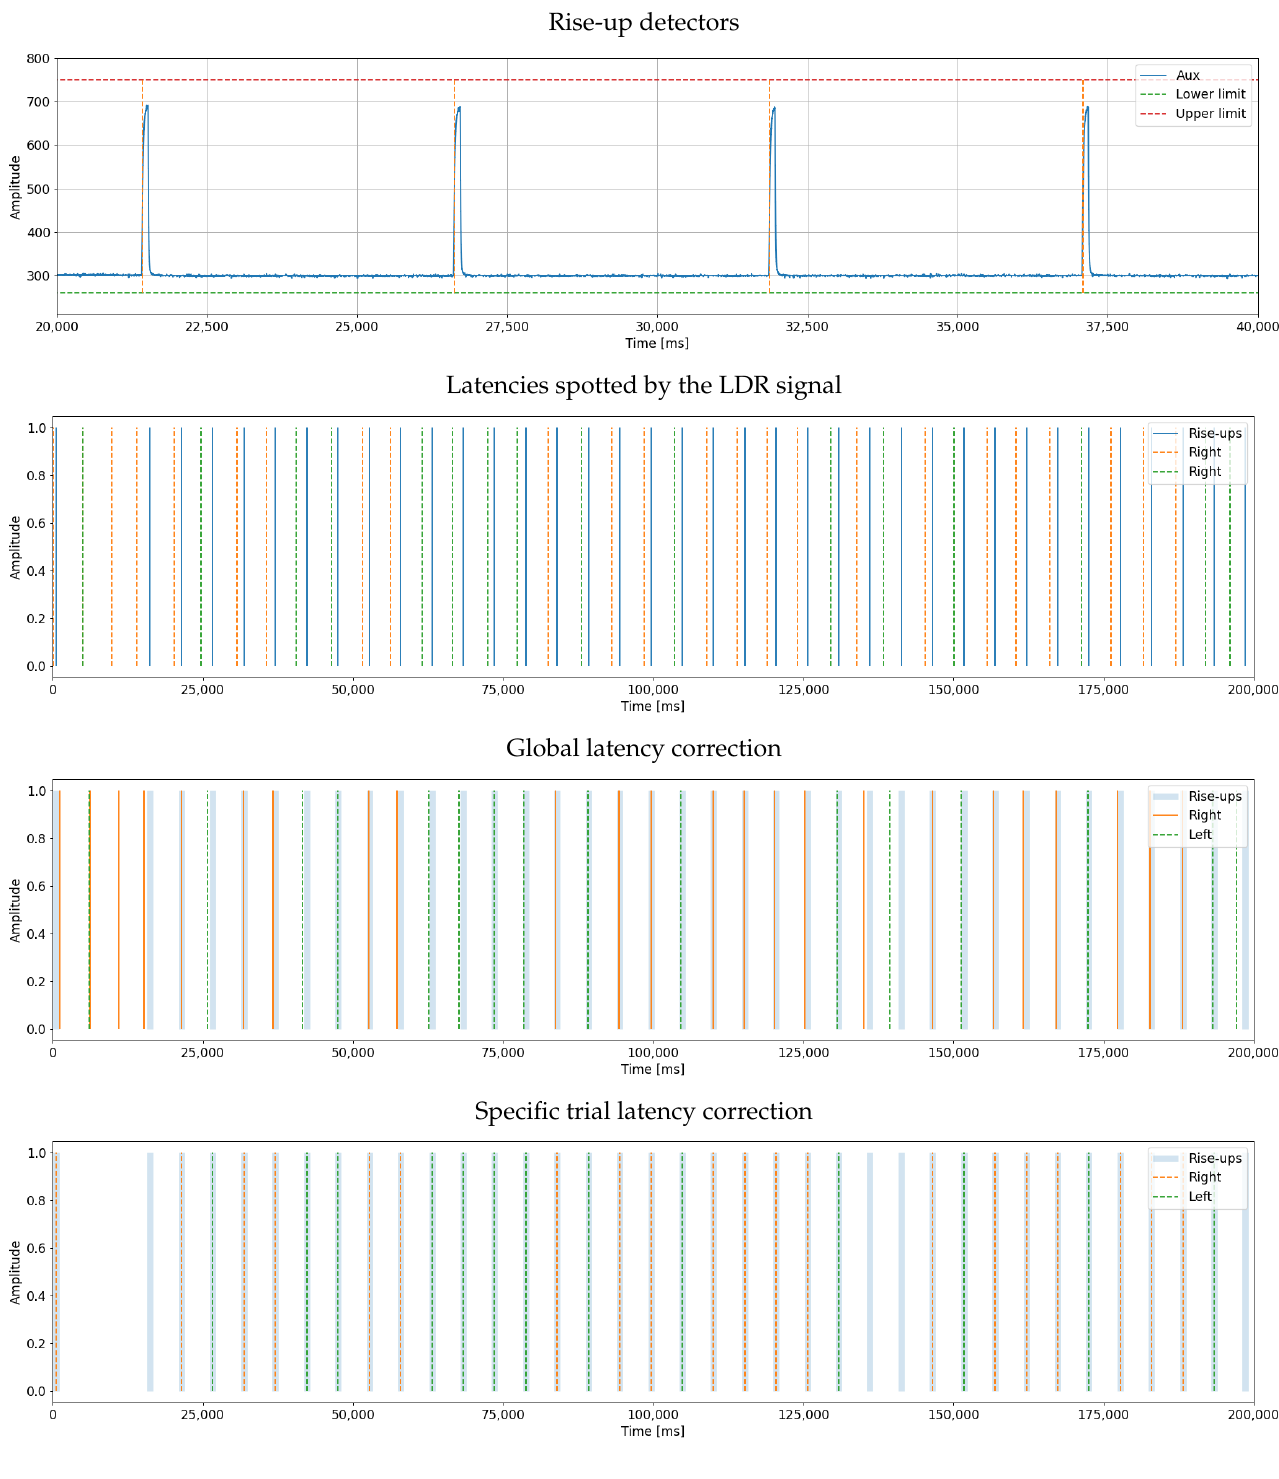
Figure 15. Automatic marker synchronization results. The top figure shows the signal generated by the LDR. The second figure visualizes the latencies in the system. The third figure shows what happens when all latencies are corrected with the same adjustment value, and the final plot has adjusted the latencies individually for each